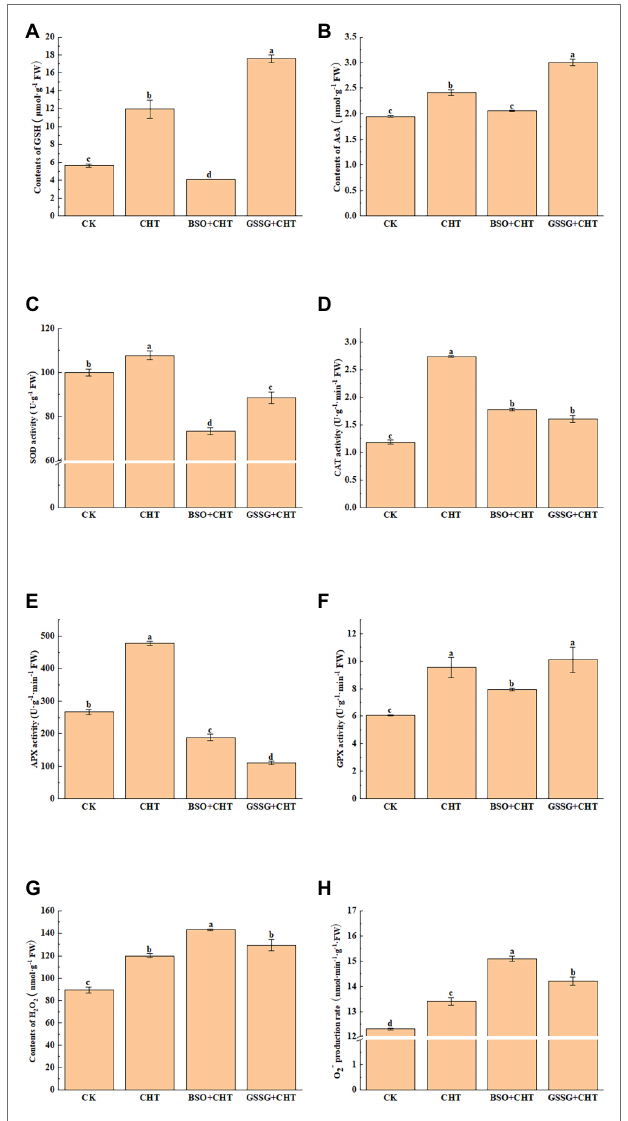
FIGURE 2 | Effects of exogenous treatment on antioxidant system in tomato. (A) GSH content. (B) AsA content. (C) SOD activity. (D) CAT activity. (E) APX activity. (F) GPX activity. (G) H 2 O 2 content. (H) O 2 − content. GSH, glutathione; AsA, ascorbic acid; SOD, superoxide dismutase; CAT, catalase; APX, ascorbate peroxidase; H 2 O 2 , hydrogen peroxide; O 2 − , superoxide anion; CHT, chlorothalonil; BSO, L-buthionine-sulfoximine; and GSSG, glutathione (oxidized). Error bars represented the SD ( n = 3). According to Duncan’s multiple test, bars with different letters were significantly different ( p <